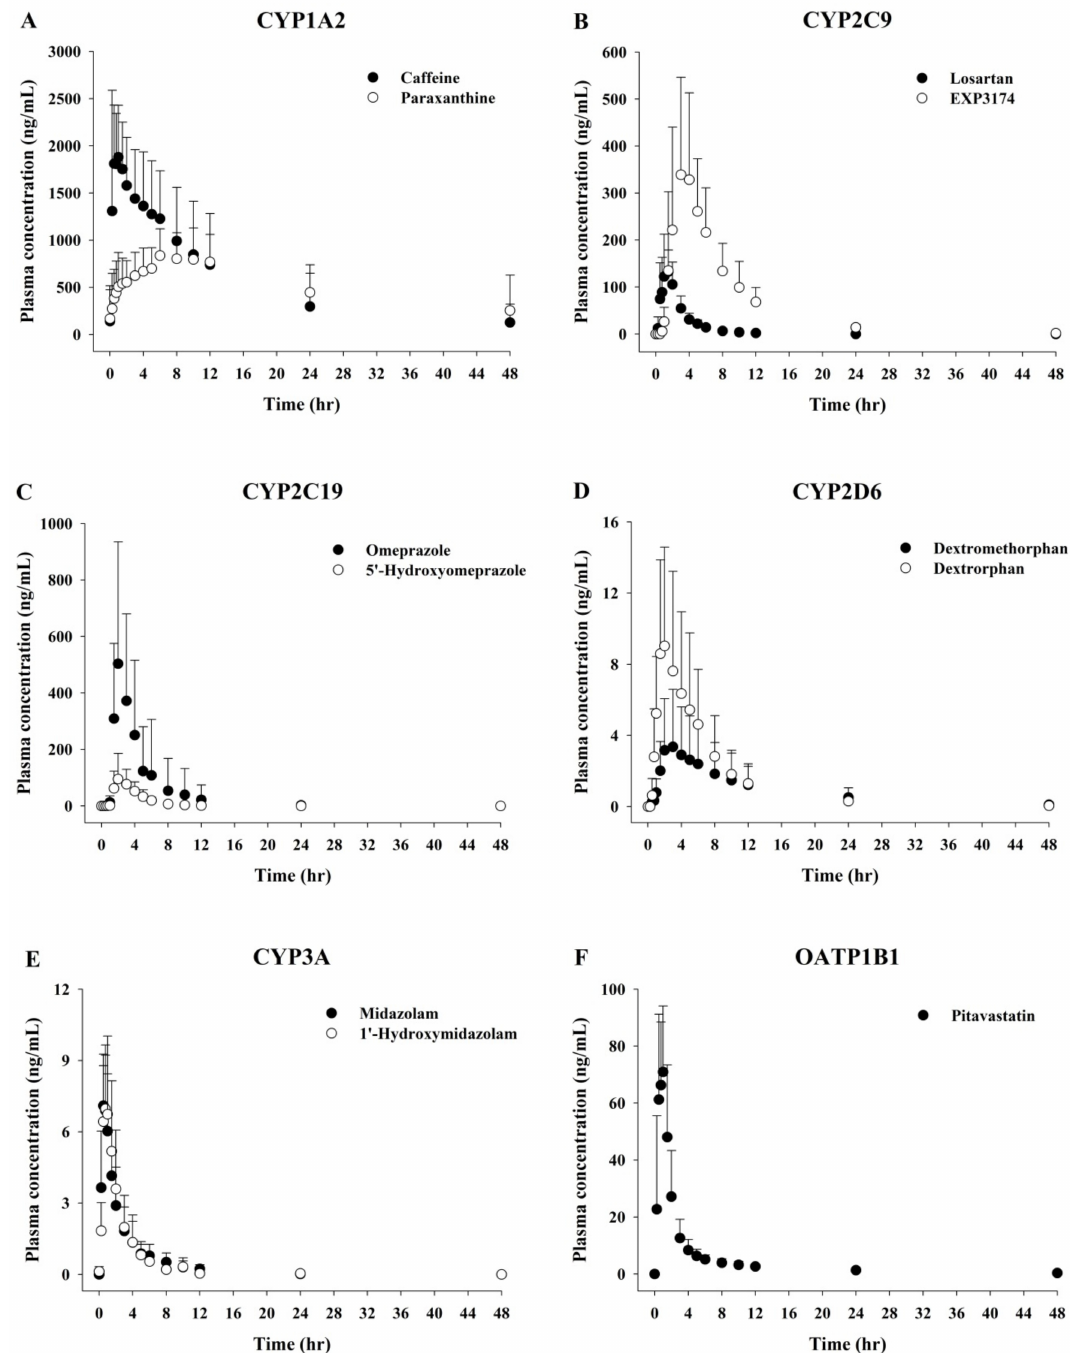
Figure 3. Mean plasma concentration-time profiles for organic anion transporting polypeptide 1B1 (OATP1B1) and cytochrome P450 probe drugs and their metabolites after administration of cocktail drugs ( n =